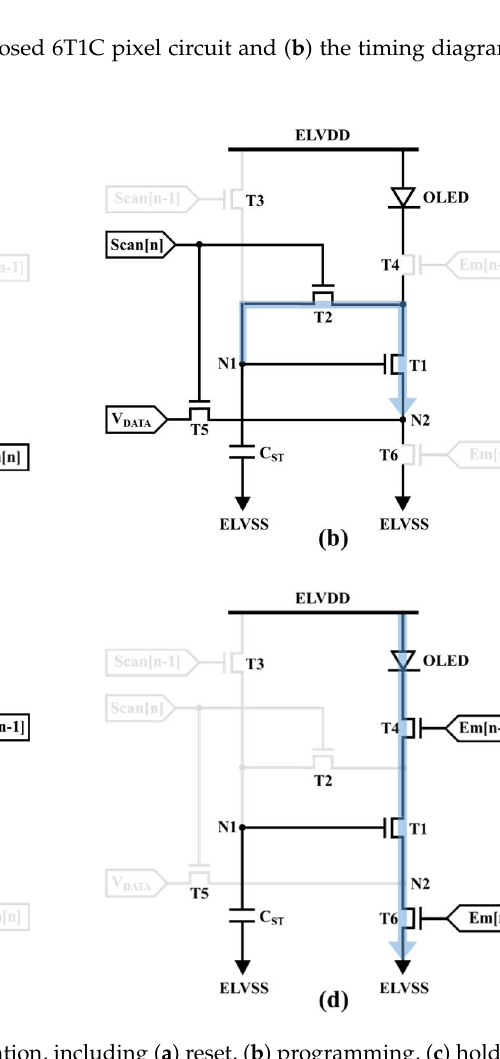
Figure 2. Schematic of pixel circuit operation, including ( a ) reset, ( b ) programming, ( c ) holding, and ( d ) emission periods.